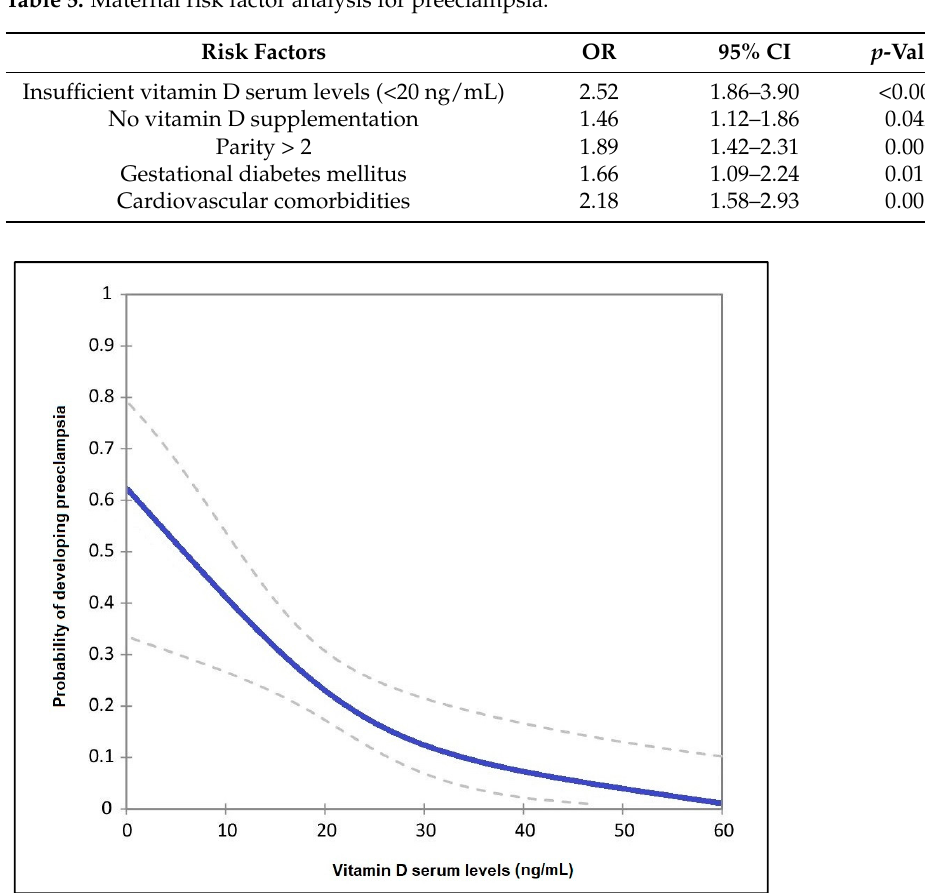
Figure 3. Adjusted probability of developing preeclampsia by levels of vitamin D. Table 5. Maternal risk factor analysis for